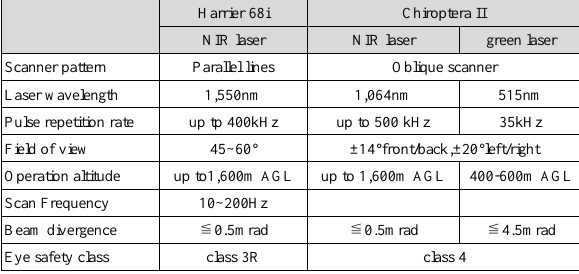
Table 1. Specifications of utilized LiDAR